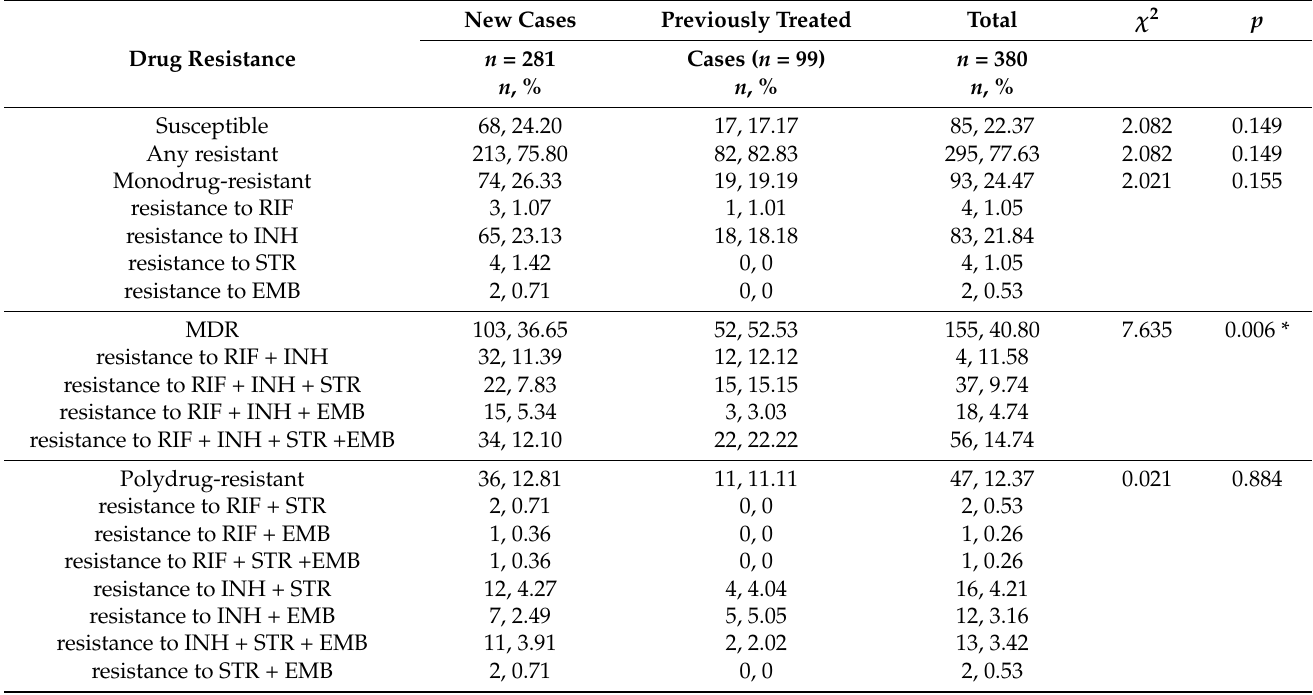
Table 2. Drug resistance of 380 MTB-positive FFPE specimens.